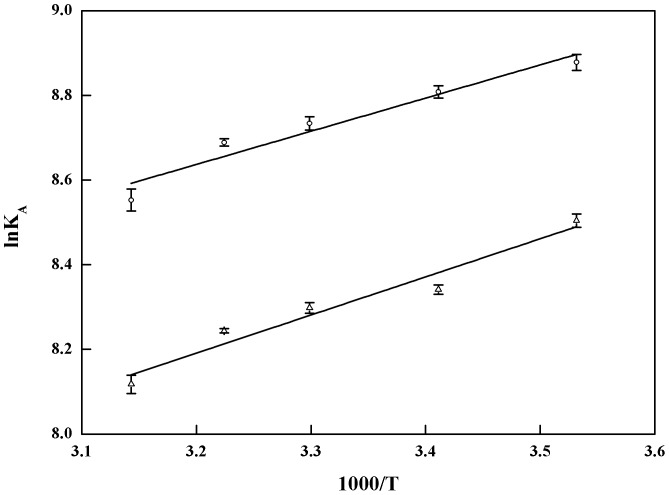
Van't Hoff plots for the interaction of ephedrine and pseudoephedrine binding to β
2-AR.Circle, best-fit line with an equation of y = (0.78±0.08)x+(6.12±0.28) for ephedrine and a coefficient of 0.9716. Triangle, Best-fit curve for pseudoephedrine with an equation of y = (0.90±0.07)x+(5.31±0.23) and a coefficient of 0.9771. All the experiments were performed at 10, 20, 30, 37 and 45 °C.